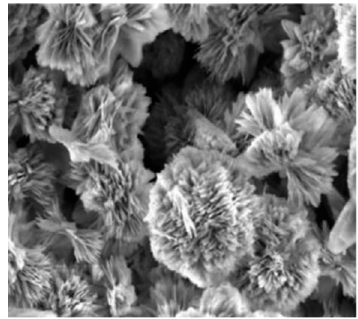
Figure 4. FESEM of ZnO micro flowers assembled by nanosheets [41].